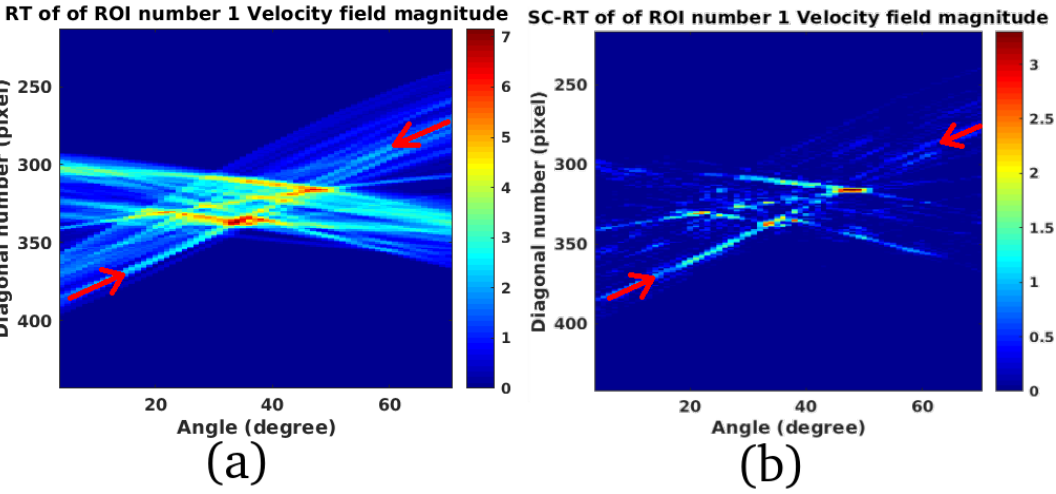
Figure 10. ( a ): RT of the displacement ROI (Particular 1 of Figure 9). ( b ): Sparse component of the RT of the displacement ROI (Particular 2 of Figure